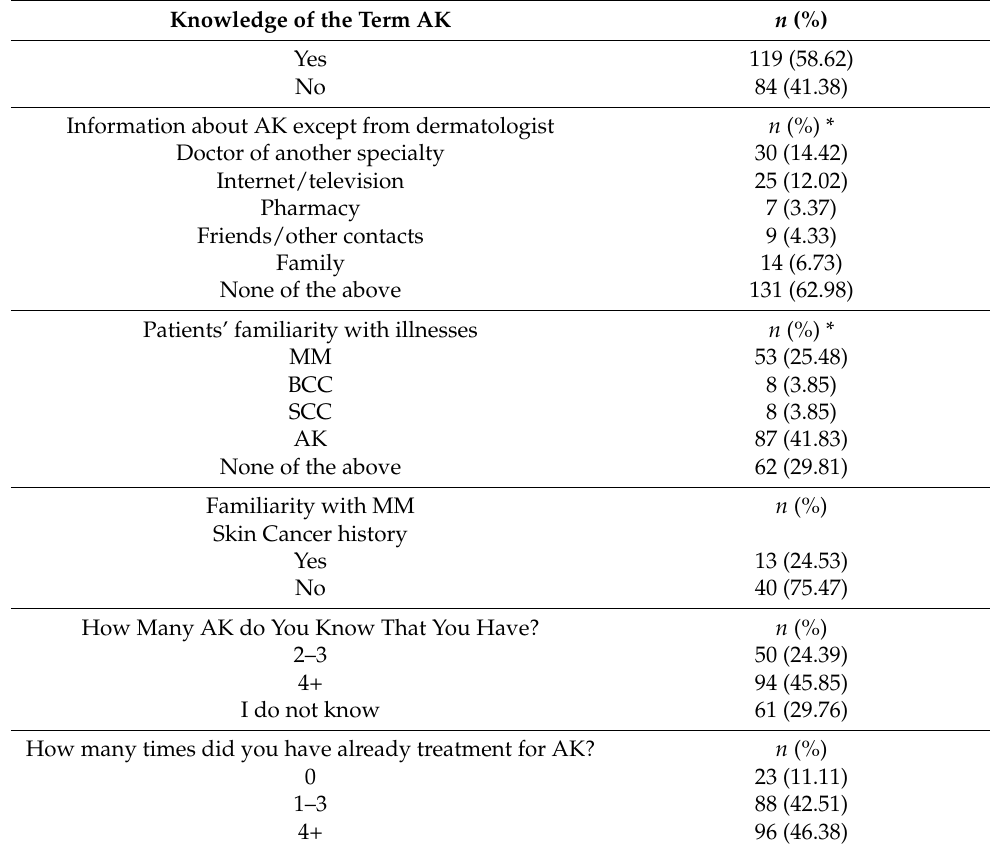
Table 2. Illness perception questions, Questionnaire Part A1.